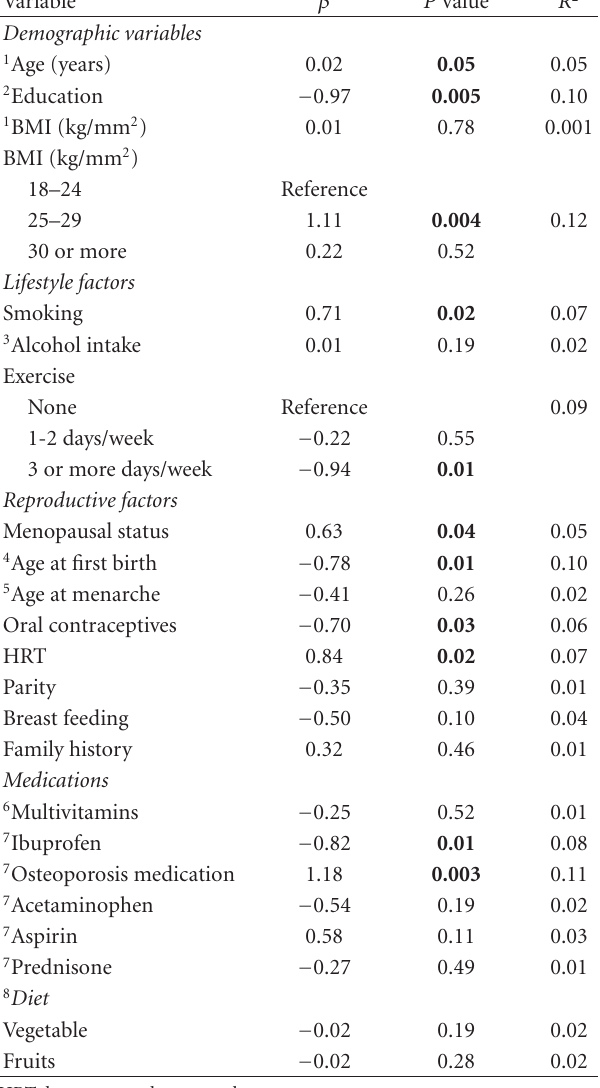
Table 2: Linear regression analyses of epidemiological predictors of regulatory T-cell (Treg) levels among 75 healthy women at Roswell Park Cancer Institute, Bu ff alo, NY, USA, 2008-2009.